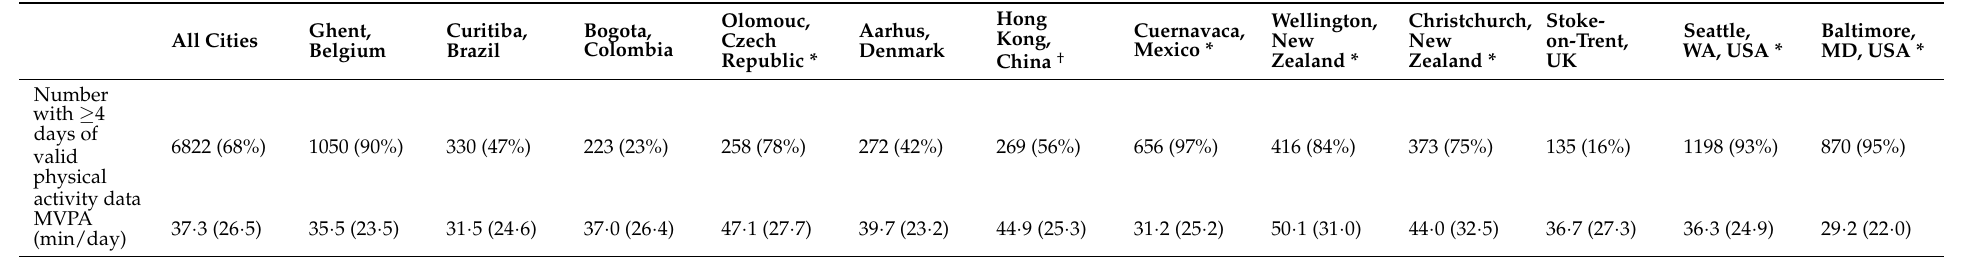
Table A1. The descriptive analysis of MVPA from different environmental settings across 10 countries of the world (modified from Sallis et al., 2016 [12]). All Cities Ghent,